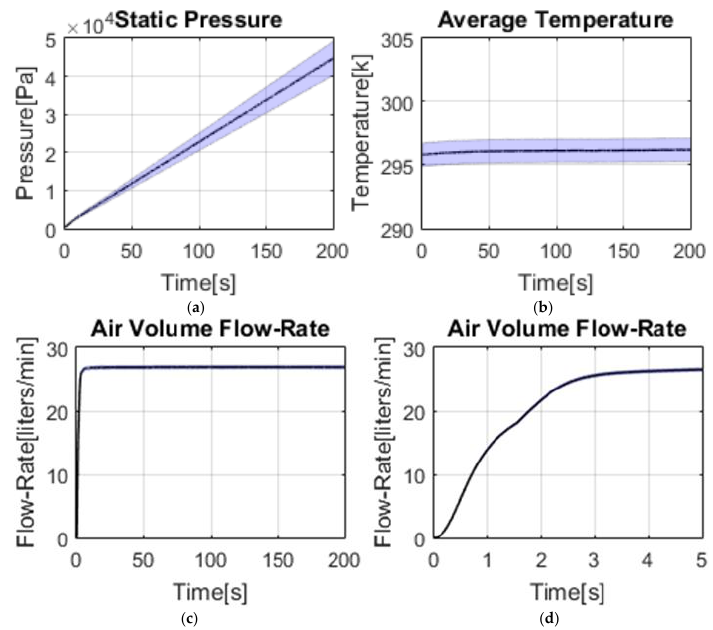
Figure 8. ( a ) Description of the pressure increase inside STARDUST-U during the air flow inlet at 27 L/min. ( b ) Description of the temperature variations measured during the experiment. ( c ) Description of the flow rate variation in the time. ( d ) Flow rate increase in the early stage from the accident experimental simulation.